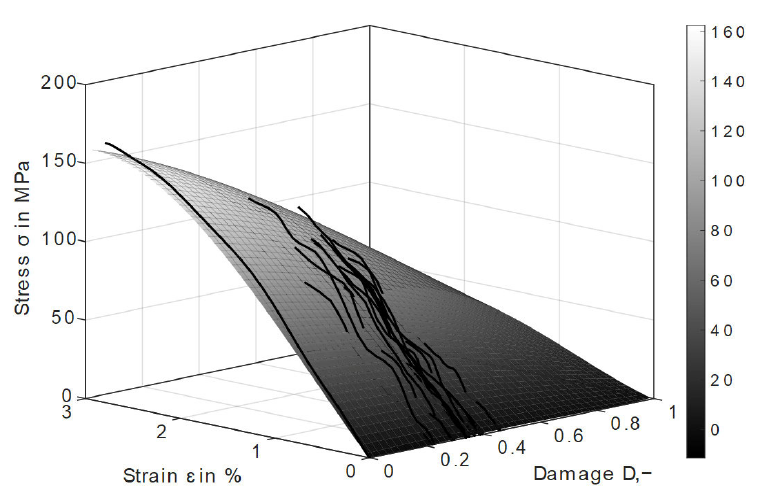
Figure 10. Recorded stress–strain curves of specimens with varying degrees of damage.